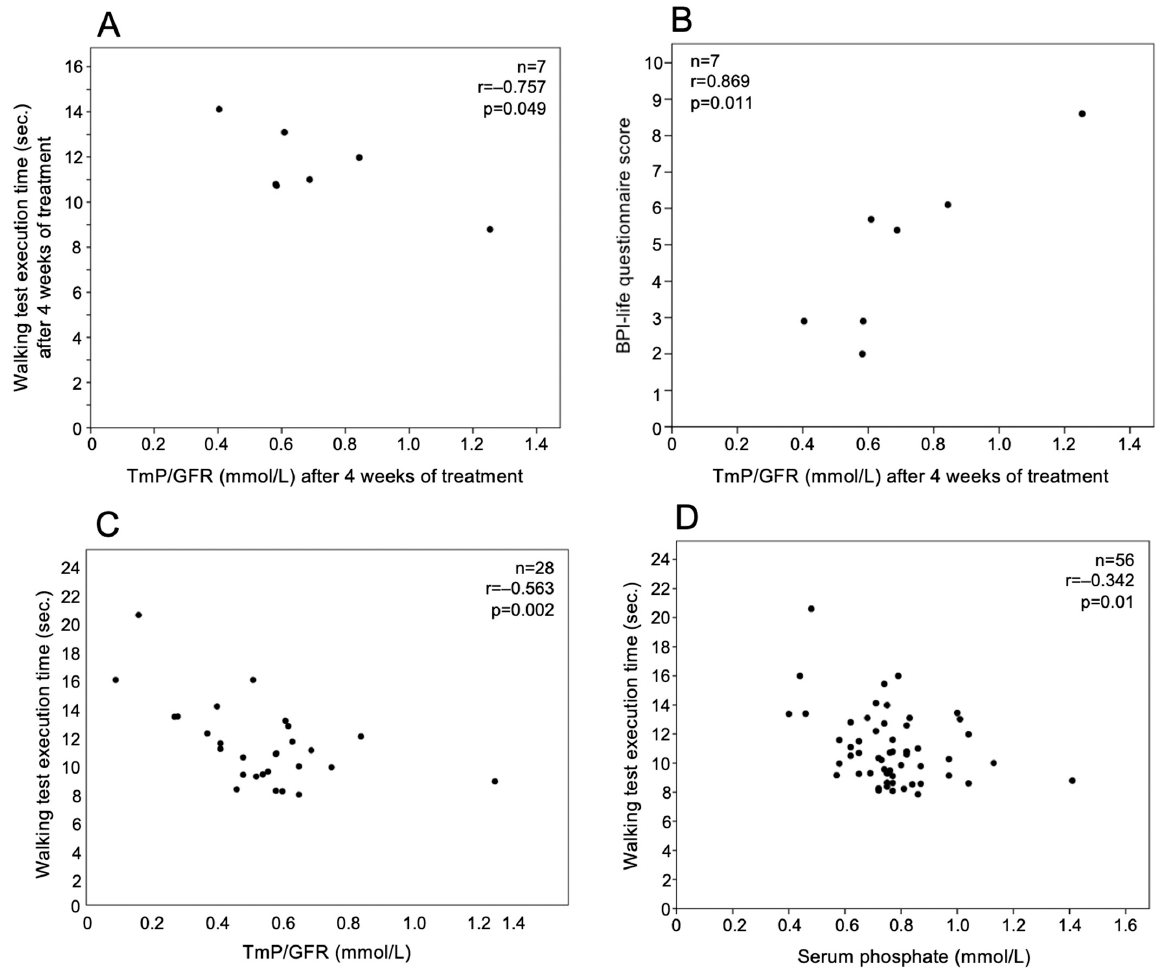
Figure 3. TmP/GFR time was correlated with ( A ) walking test execution time and ( B ) BPI-life score at the 4th week of burosumab treatment in 7 patients with XLH. Considering together all the determinations at different times, walking test execution time was correlated with ( C ) TmP/GFR and ( D ) serum phosphate.